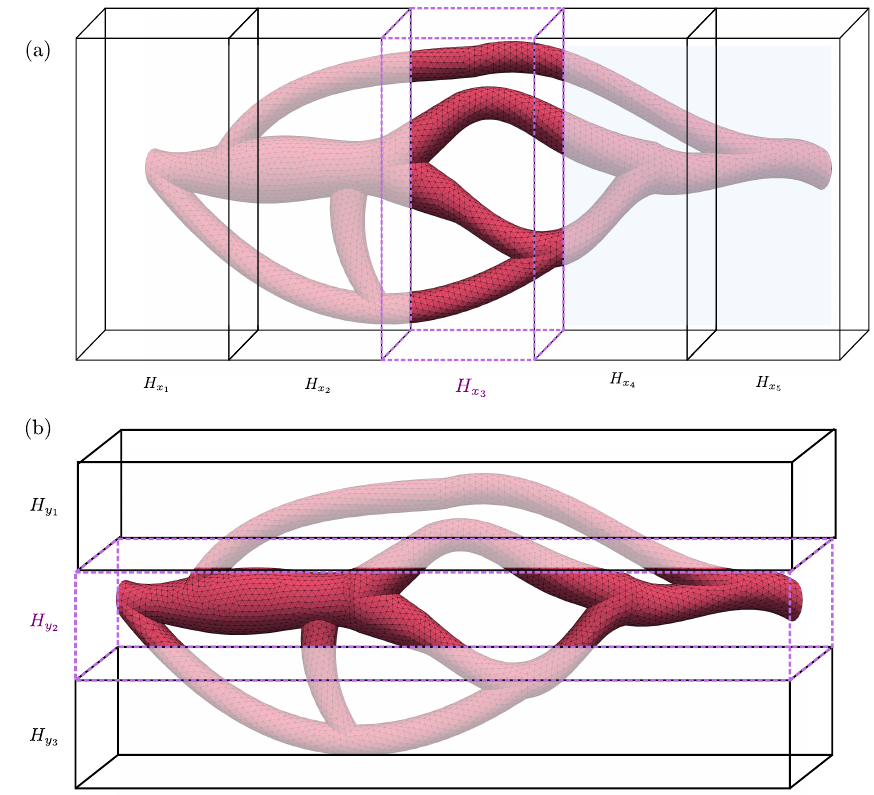
Figure 5. ( a ) Subdivision of the computational domain along y into 5 subdivisions: H x node belongs to H x , the loop over the set of triangles is reduced to the triangles belonging to H x 3 ( b ) Subdivision of the computational domain along x into 3 subdivisions: H y belongs to H y , the loop over the set of triangles is reduced to the triangles belonging to H y 2